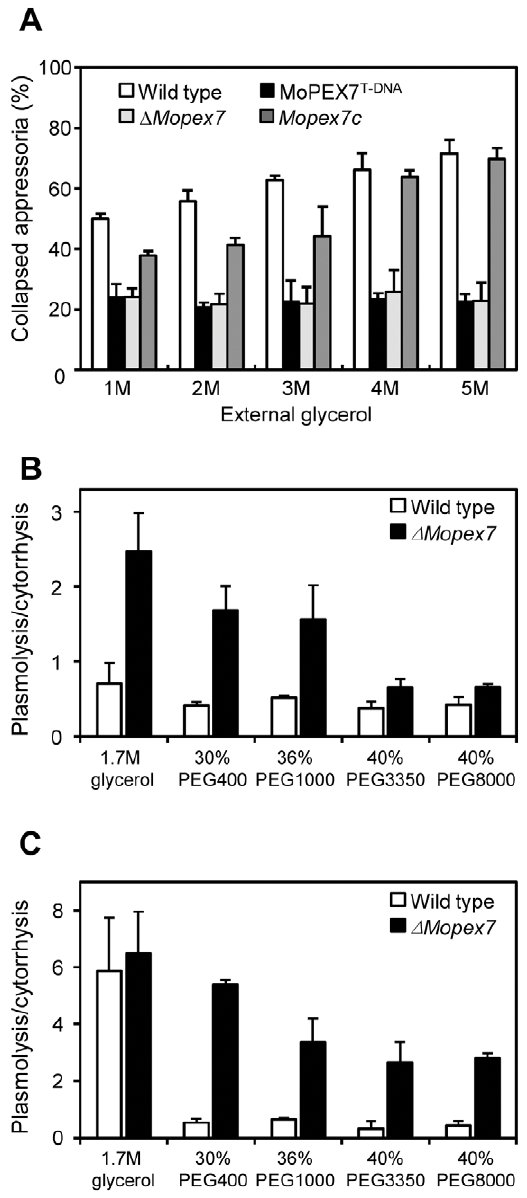
Figure 6. Measurement of turgor pressure and appressorial porosity. (A) Cytorrhysis assay using glycerol at 48 h. (B) Cytorrhysis assay with various osmotic solutions. (C) Cytorrhysis assay with various osmotic solutions after treatment of 4 m g/ml tricyclazole. External osmotic solution was given to appressoria after 48 h. Concentrations were adjusted to 4 MPa osmotic pressure; 1.7 M glycerol, 30% PEG400, 36% PEG1000, 40% PEG3350 and 40% PEG8000 were used as external osmotic solution. Appressorial cytorrhysis and plasmolysis were counted under a microscope. The ratio of plasmolysis to cytorrhysis was the average of three replications.